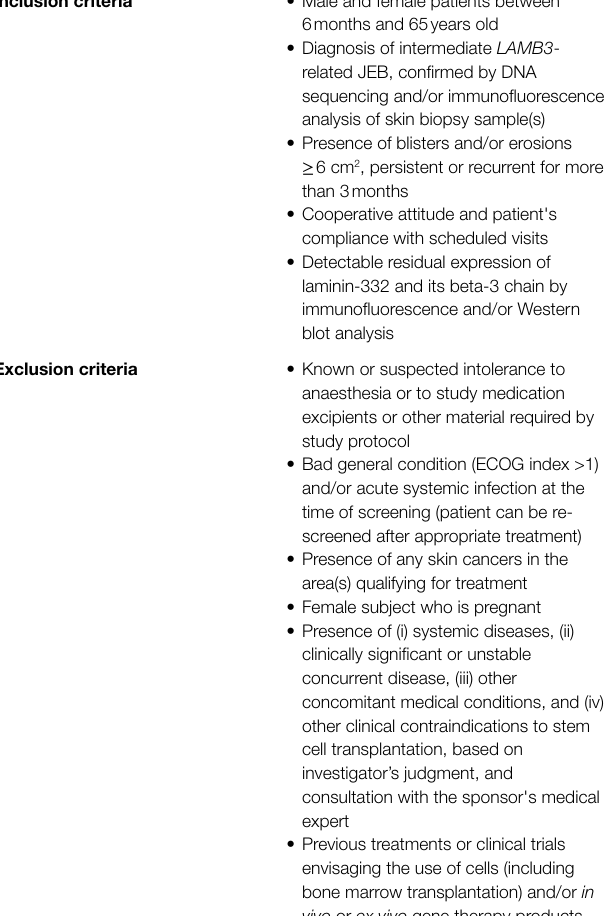
TABLE 2 | Eligibility criteria for Hologene 5.